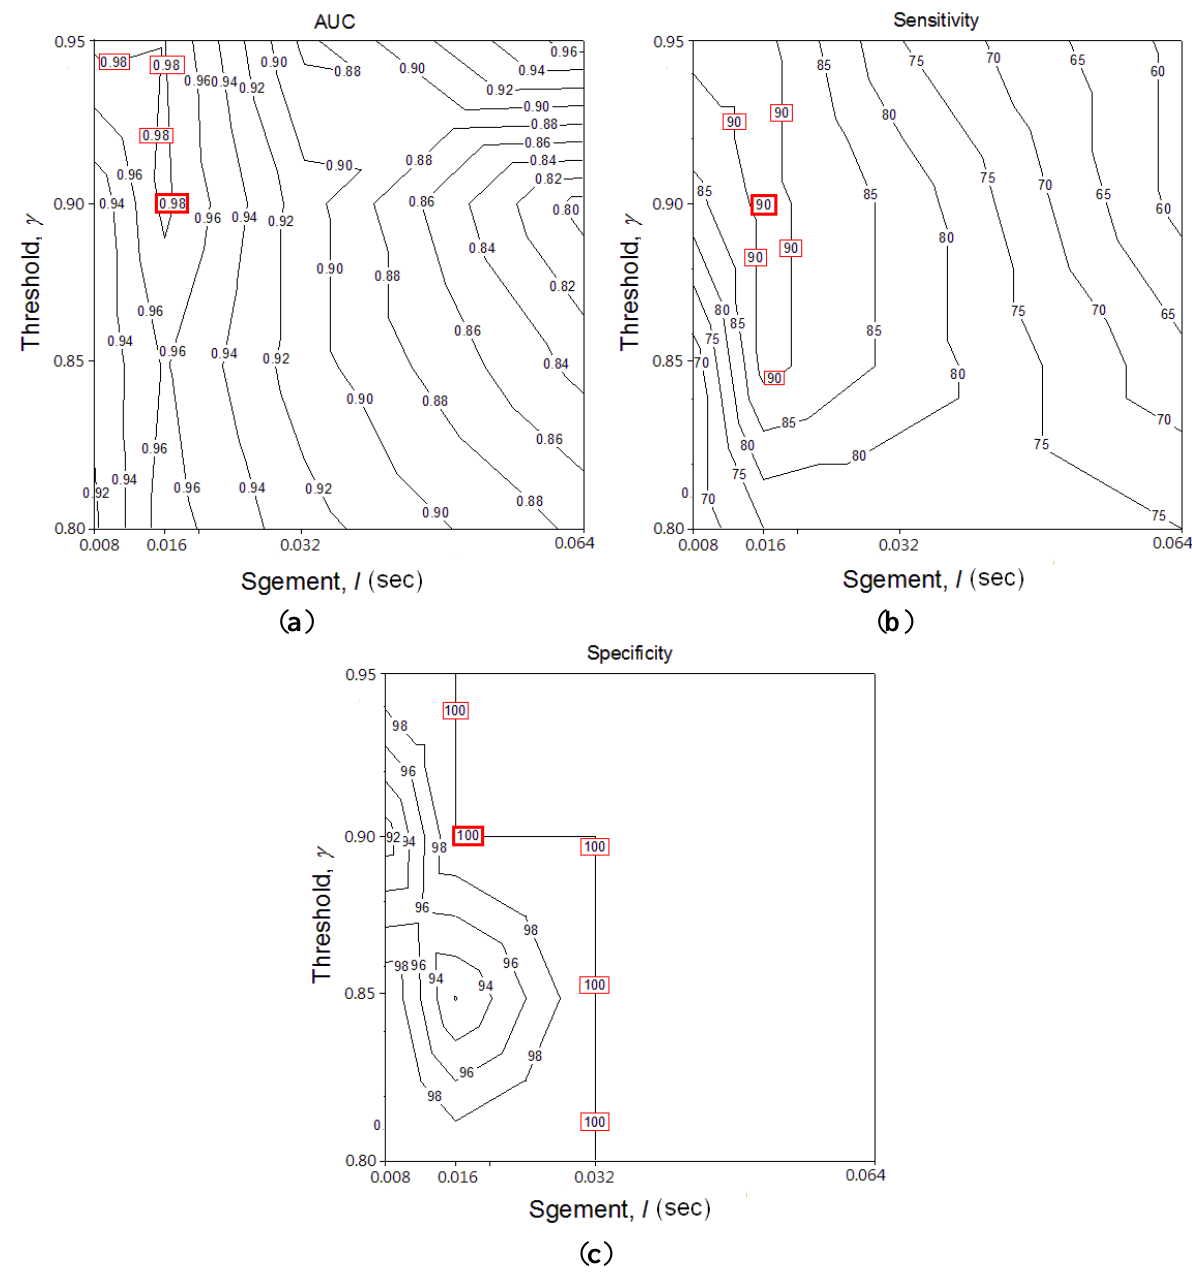
Figure 4. Contour graph of the ROC result with different l and ε . ( a ) is the AUC; ( b ) is sensitivity and ( c ) is